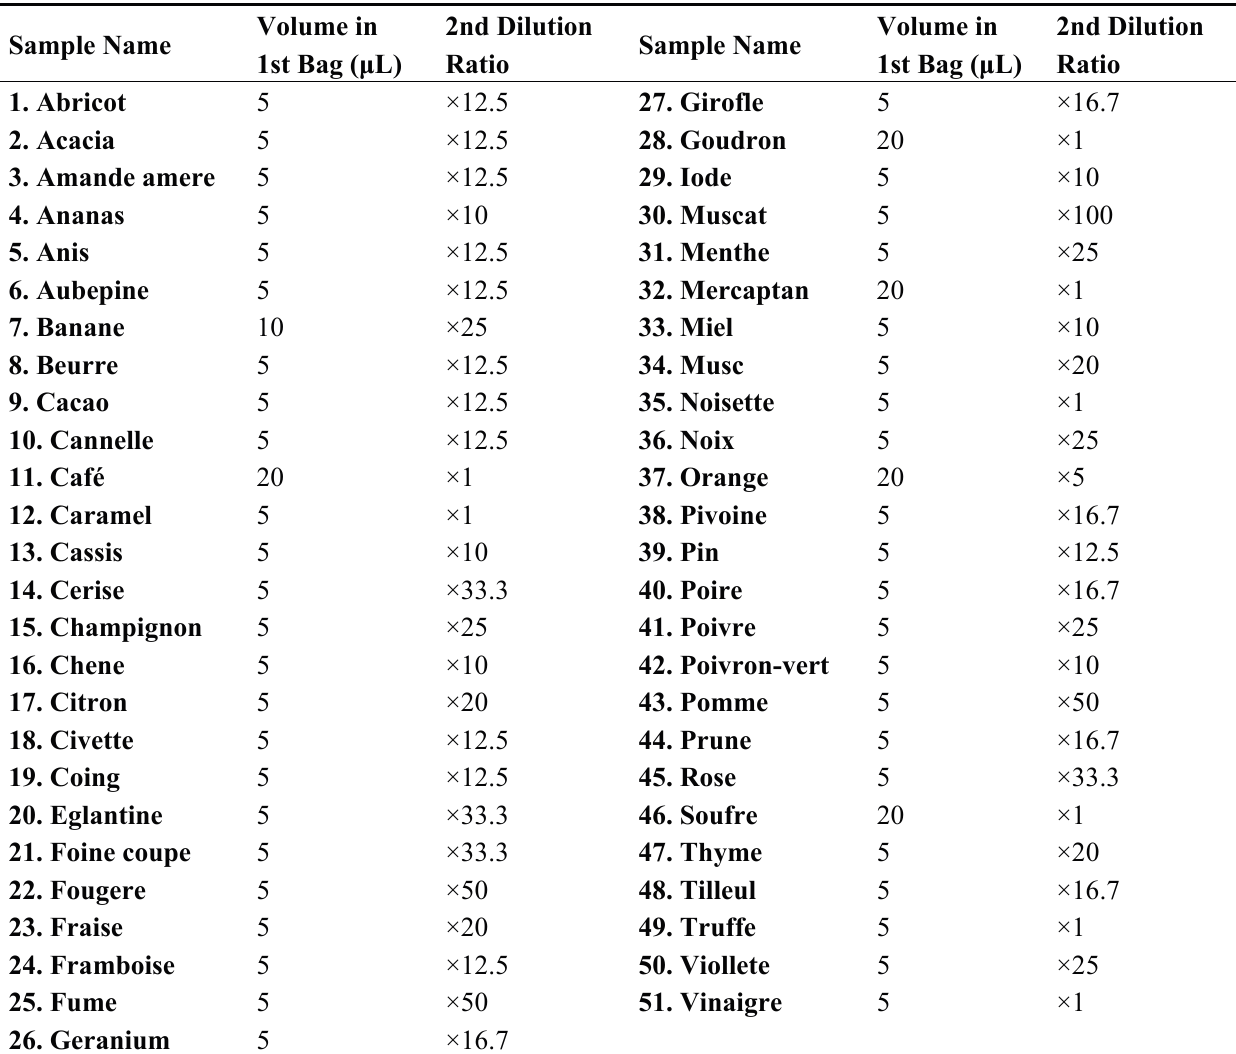
Table 2. Volume and dilution ratios of flavor